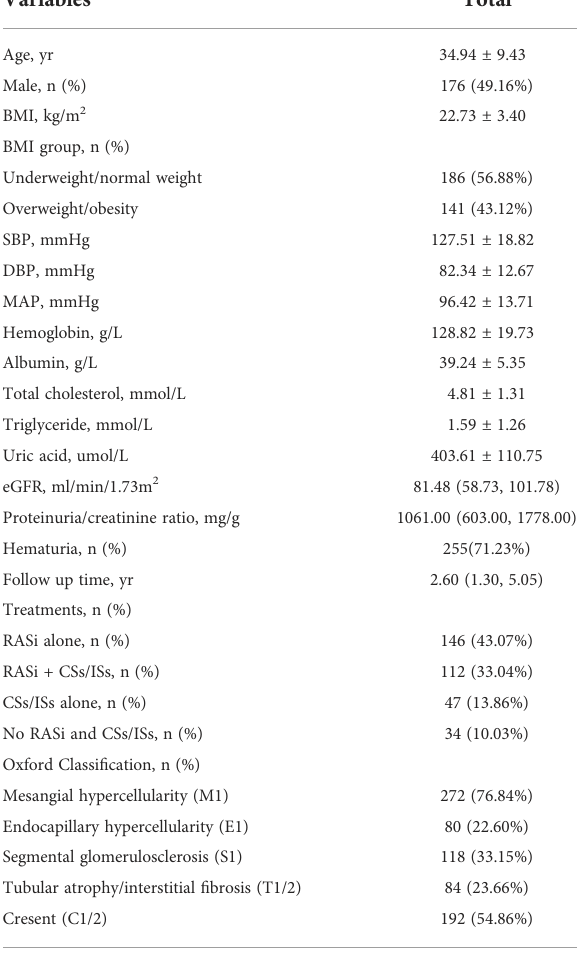
TABLE 1 Baseline characteristics and pathological features of IgAN